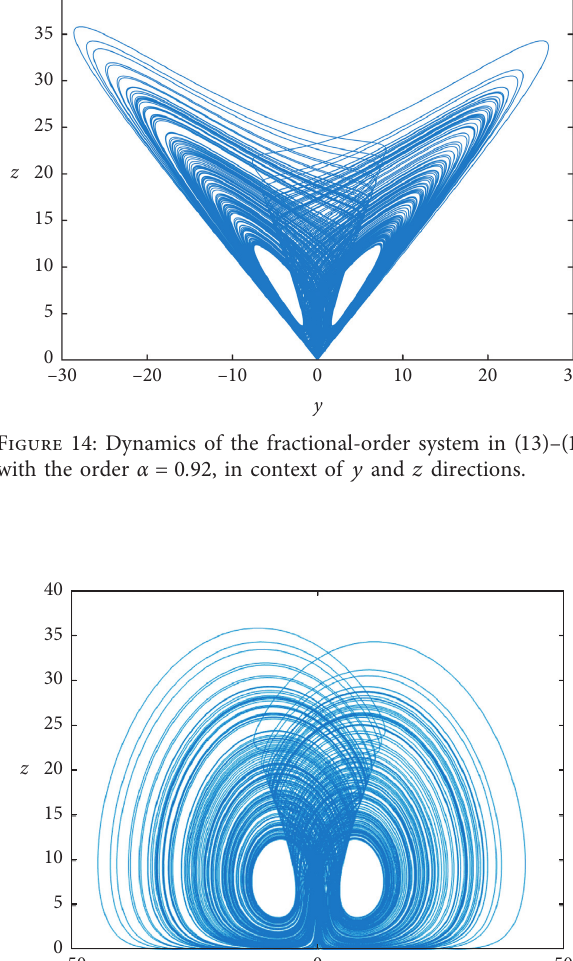
Figure 16: Dynamics of Lu et al.’s fractional-order system in (13)–(15) with the order α � 0 . 92, in context of x and y directions. Table 1: Lyapunov exponents.